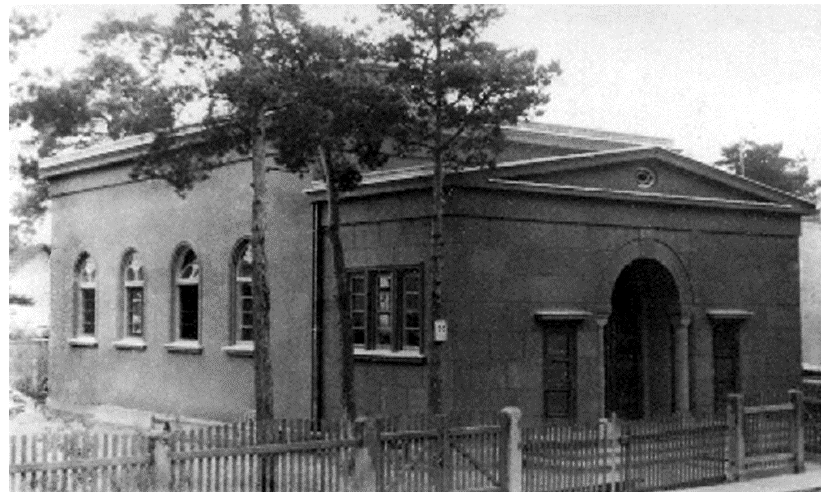
Figure 16. Bulduri Synagogue, Saldus Street, architect B. Kļaviņš, 1938. © Association “Shamir”. Used by permission.